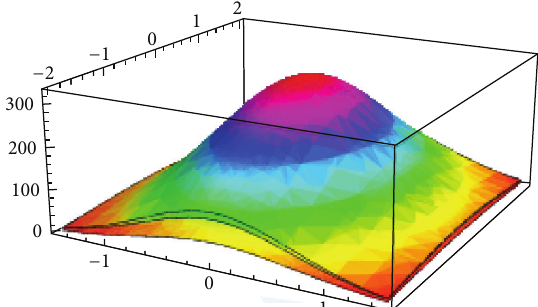
Figure 7: Dimensional graph of the fuzzy solution for 𝑡 = 20 involving only diffusion.